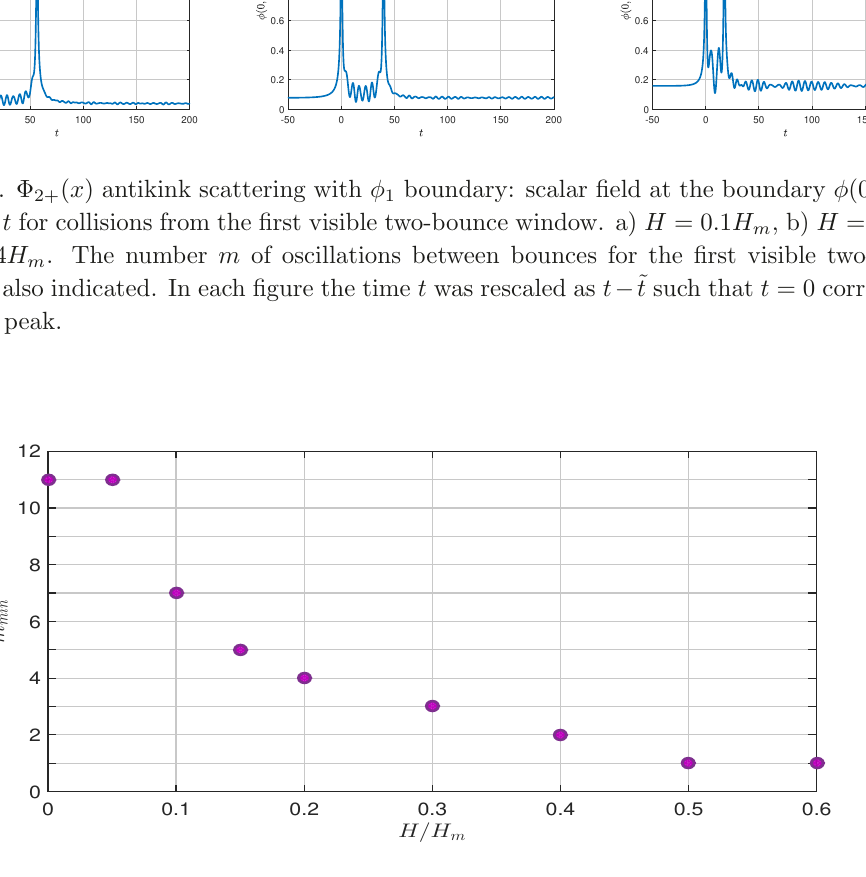
Figure 15 . Φ 2+ ( x ) antikink scattering with φ 1 boundary: order of first two-bounce windows as a function of H/H m